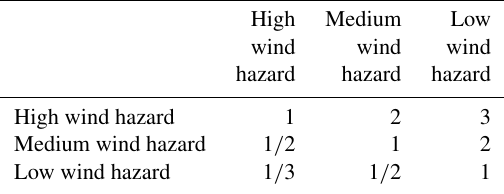
Table A6. Judgement matrix adopted for the calibration of the hazard parameters.